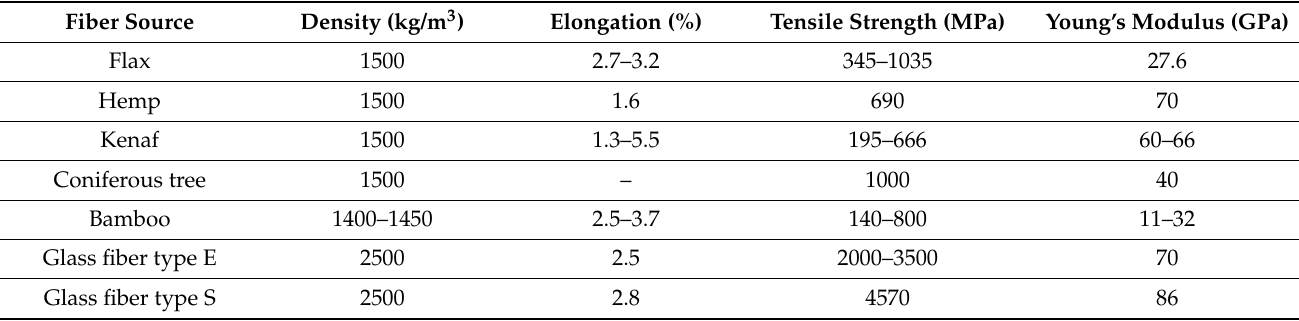
Table 1. Physico-chemical properties of some fibers used as fillers in polymer matrix [11,13].